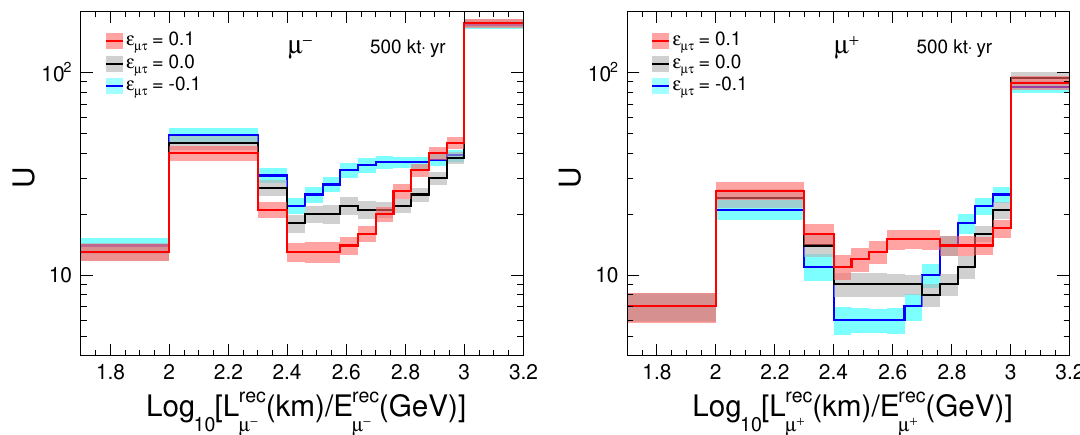
[ L rec ] distributions of µ − and µ + events in left and right panels, re- Figure 3 . The log /E rec 10 µ µ spectively, expected in 10 years at ICAL. The black lines correspond to SI ( ε red and blue lines are for ε = 0 . 1 and -0.1, respectively. The statistical uncertainties shown by µτ shaded boxes are the root-mean square (rms) fluctuations of 100 independent 10-year data sets. The solid lines show the mean of these 100 distributions. We consider normal mass ordering, and the benchmark oscillation parameters given in table 2.